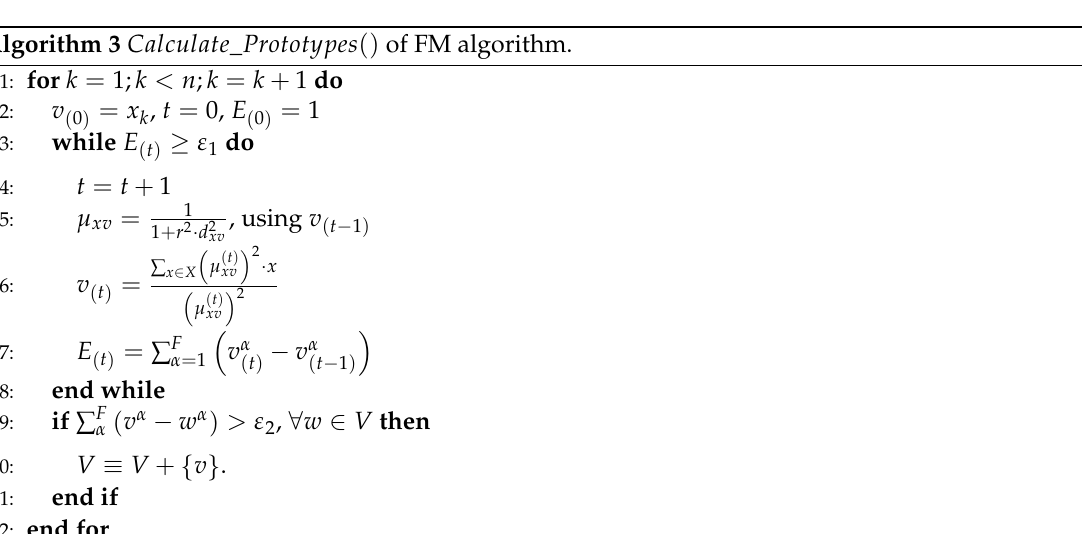
Algorithm 3 Calculate _ Prototypes () of FM